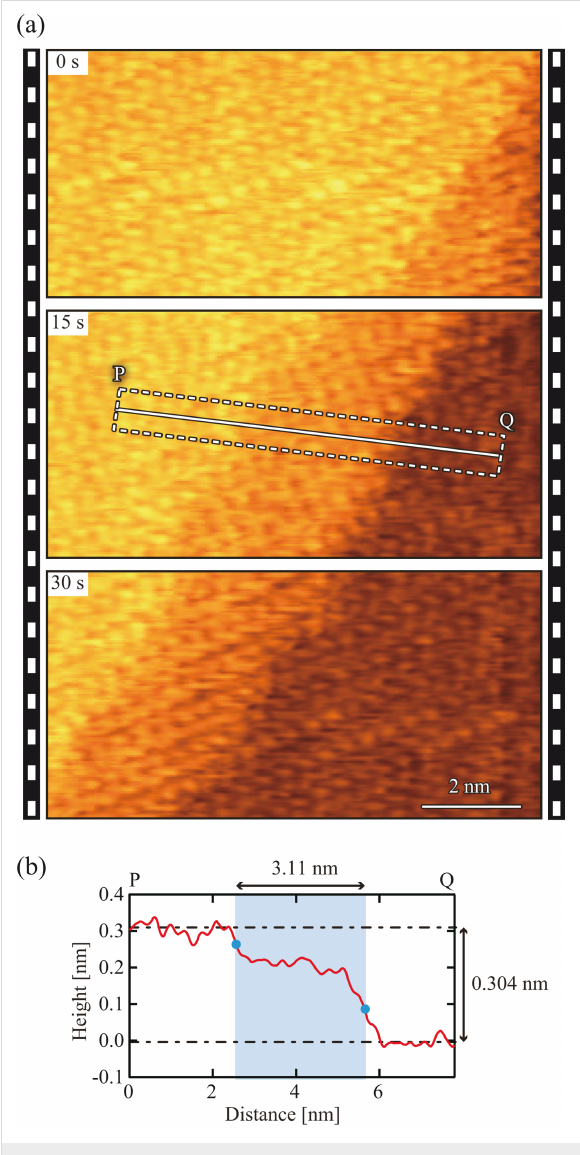
Figure 9: (a) High-speed FM-AFM images of calcite (10 − 14) surface obtained in water at 0.5 s/frame (10 × 5 nm 2 , 500 × 250 pix 2 ). (b) Height profile measured along line PQ in panel (a). The profile was averaged over the width indicated by the dotted